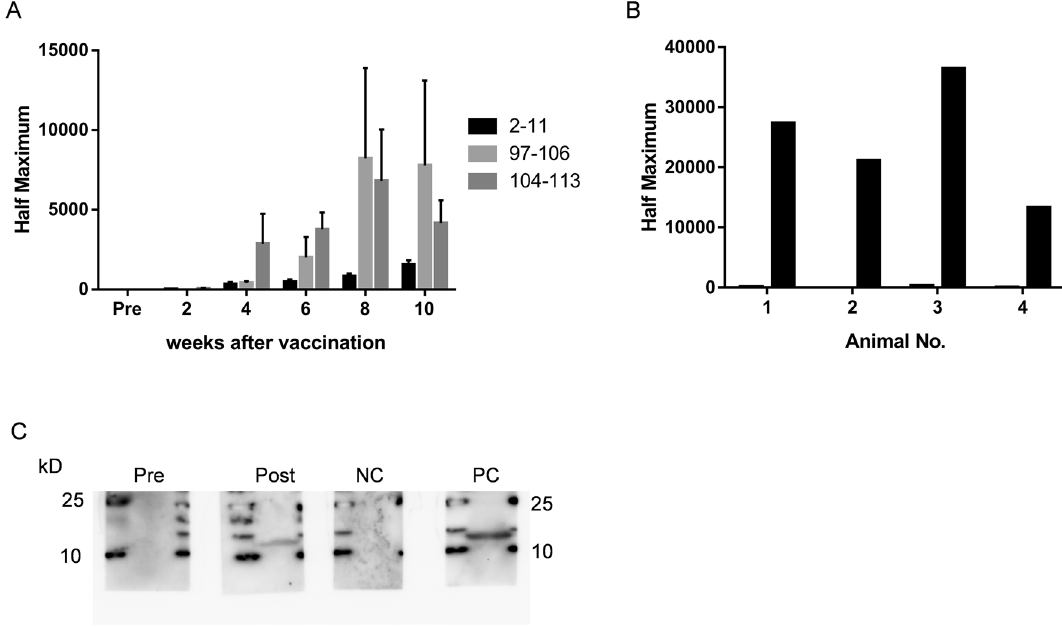
Figure 2. Production of antibody against S100A9 by vaccination. ( A,B ) The antibody titers against the epitope in mice ( A ) and monkeys ( B ). ( A ) The epitopes in C-terminus (97–106 aa and 104–113 aa) are more effective than that in N-terminus (2–11 aa). Data represent the mean ± SEM of n = 3 in each group. ( B ) Antibody titers before (left bar) and after (right bar) the vaccine are presented. All monkeys were successfully vaccinated. ( C ) Western blot analysis for production of antibodies specific for recombinant human S100A9 protein (14 kDa) in No. 4 monkey. The serum samples from pre-vaccination (Pre) and post-vaccination (Post) were examined to determine whether they included antibodies that recognize recombinant S100A9 protein. The commercially available anti-S100A9 antibody (PC) or IgG purified from another normal monkey (NC) was used as a positive control or a negative control,